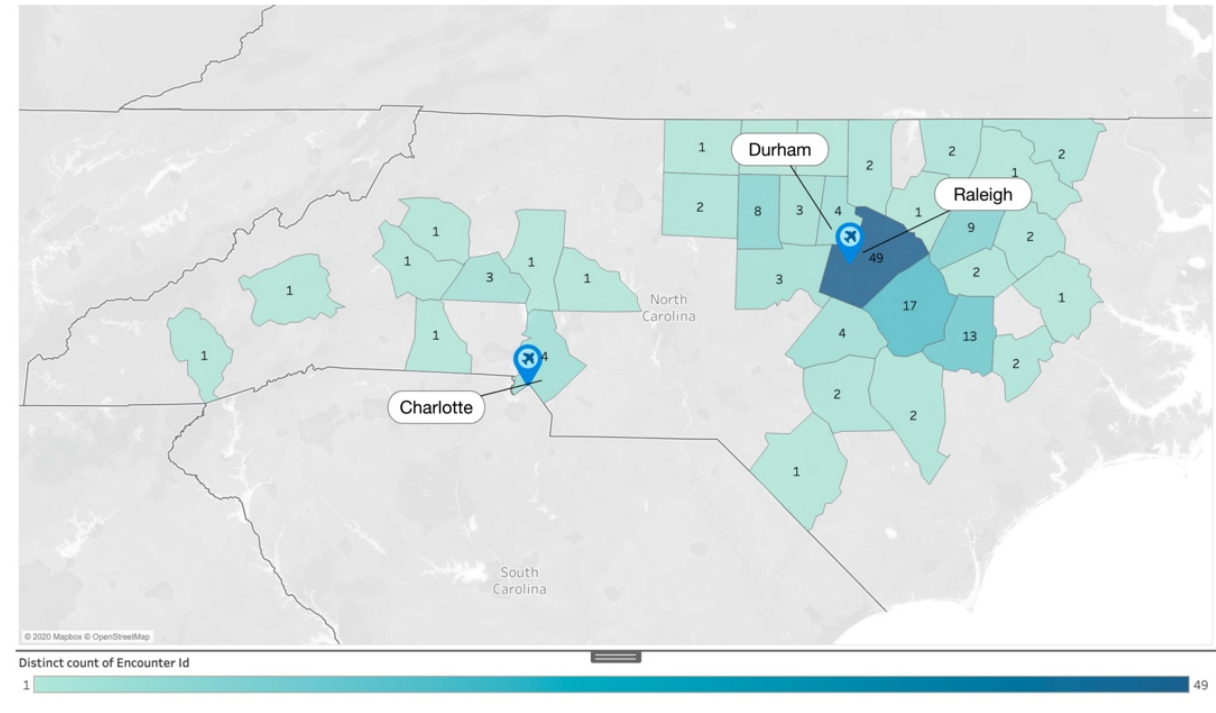
Figure 3. Quantification of virtual care visits from February 1 to 28,